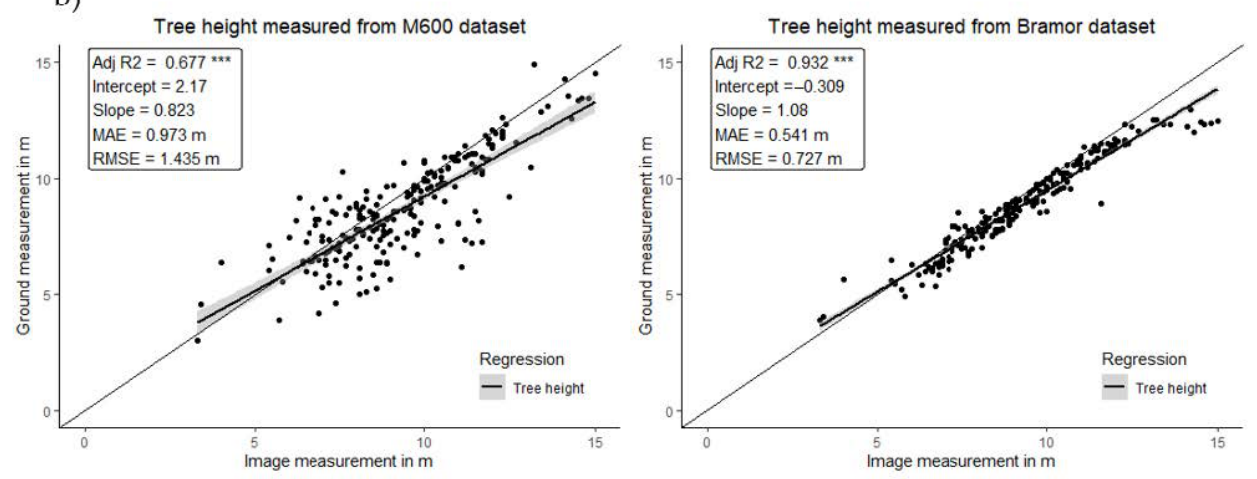
Figure 5. Results of regression analysis between ground-measured and algorithm-derived estimates for the red oak plantation. ( a ) Crown diameter measured using different UAS datasets (M600 and Bramor, respectively). ( b ) Tree height measured using different UAS datasets (DJI Mavic 600 and Bramor, respectively). *** indicates p ≤ 0.001 (statistical significance).